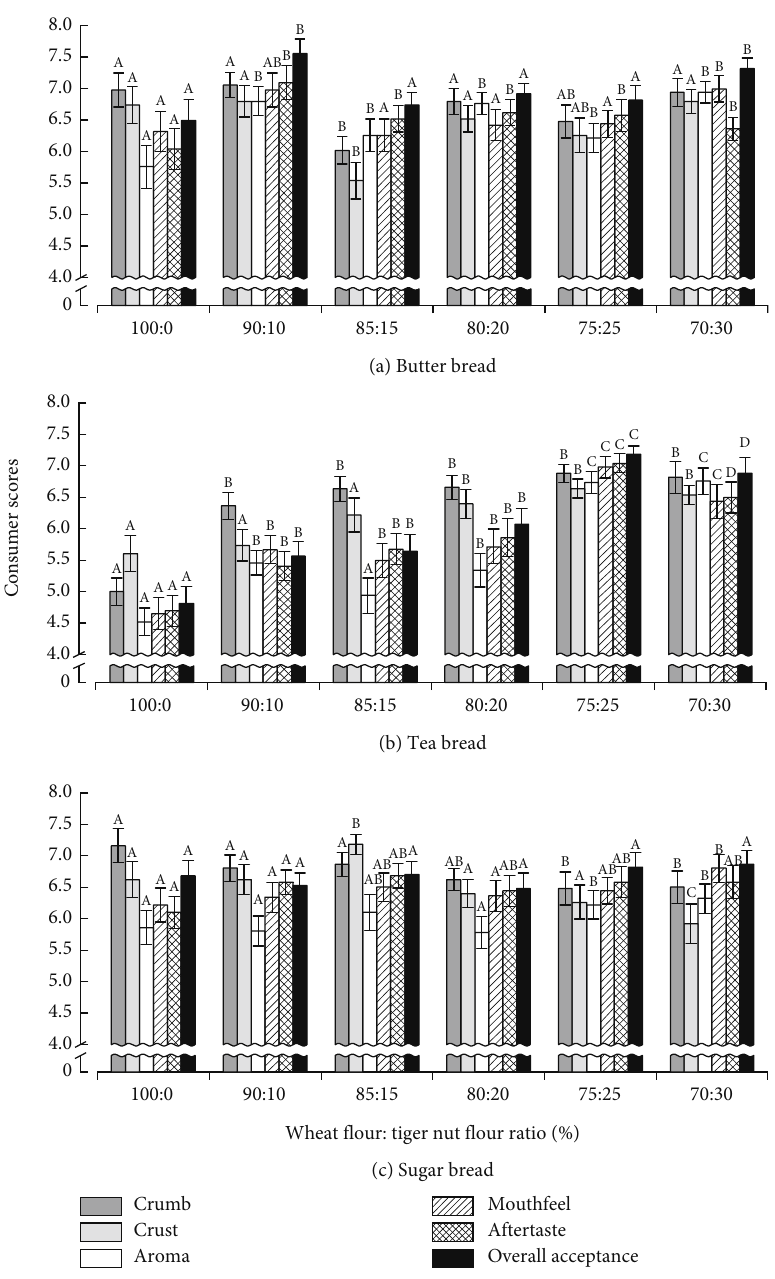
Figure 5: E ff ects of substituting wheat fl our with tiger nut fl our on the consumer scores for butter bread, tea bread, and sugar bread. Bars with similar colors marked with di ff erent letters are signi fi cantly di ff erent at p < 0 : 05 , N = 56